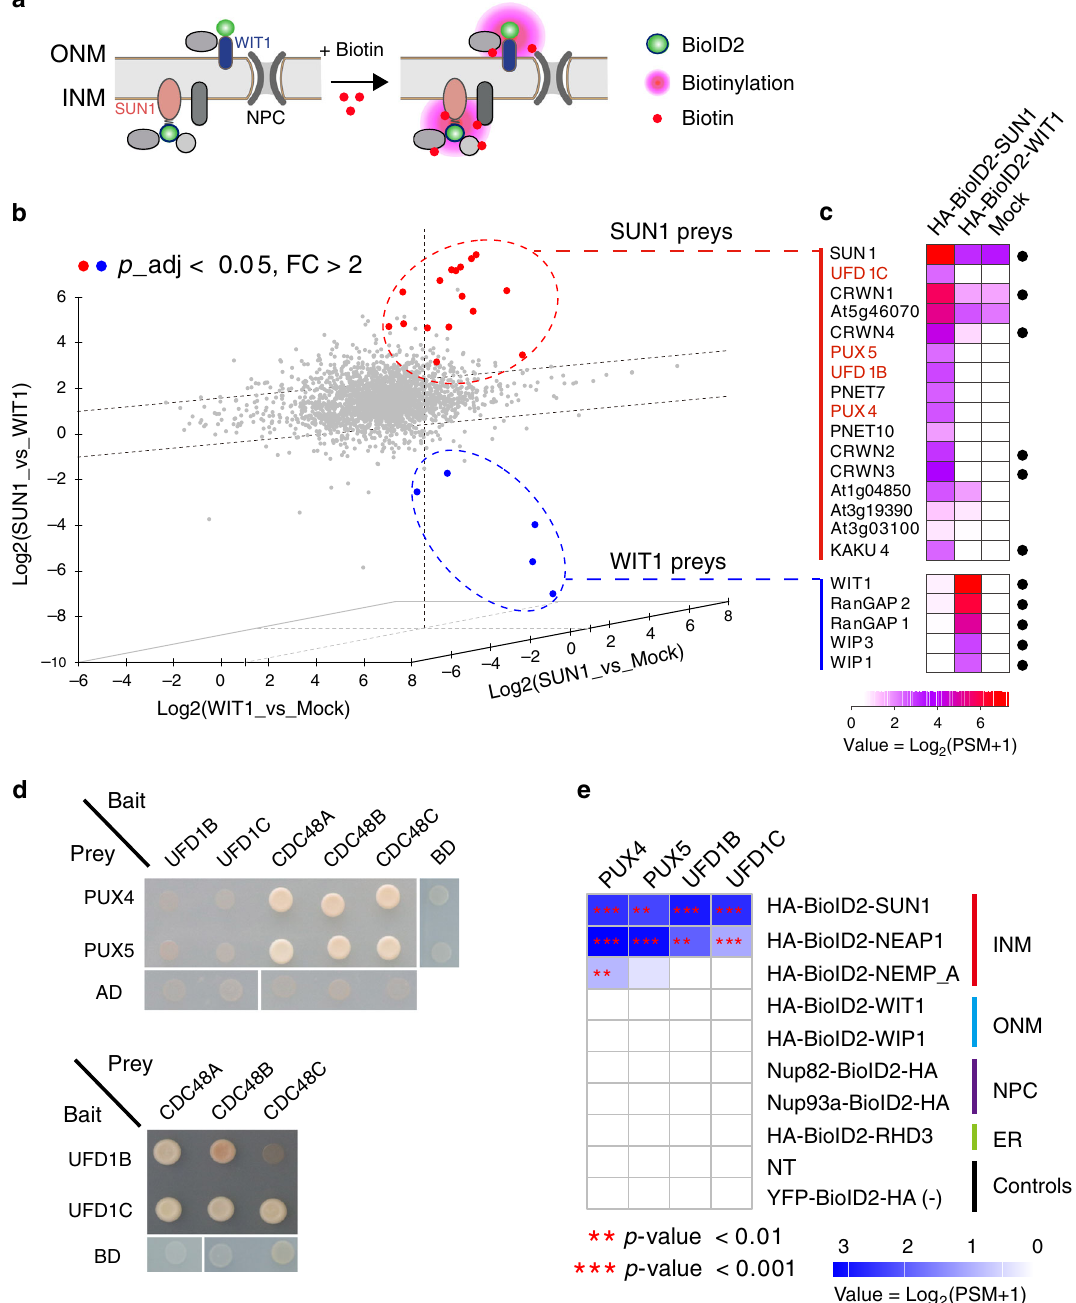
Fig. 1 The CDC48-dependent proteolysis machinery associates with integral INM proteins. a Identi fi cation of proteins that are speci fi cally associated with SUN1 at the INM using proximity labeling. The ONM protein WIT1 serves as a control to exclude proteins associated with both the INM and the ONM. b Pairwise ratiometric analyses of PL-LFQMS data using 35S: HA-BioID2-SUN1 ( + biotin), 35S: HA-BioID2-WIT1 ( + biotin), and 35S: YFP-BioID2-HA ( − biotin) samples. Three biological replicates for each sample were included in the analyses. Axes represent the log values of peptide intensity ratio (FC, fold-change) between two samples. Signi fi cantly enriched proteins in one sample were de fi ned by cutoffs FC>2 and adjusted p -value < 0.05 (linear model F -test) relative to both controls. Proteins signi fi cantly enriched in HA-BioID2-SUN1 and HA-BioID2-WIT1 samples are labeled in red and blue dots, respectively. c Heatmap showing transformed and averaged peptide spectrum match (PSM) values of signi fi cantly enriched proteins in HA-BioID2-SUN1 and HA-BioID2-WIT1 samples. Known SUN1 and WIT1 interacting proteins are marked by black dots on the right. d Yeast-two-hybrid analyses among PUX4/5, UFD1B/1C, and CDC48A/B/C. Diploid yeasts after mating were grown on QDO medium (SD-Leu/-Trp/-His/-Ade) for 3 days. Similar results have been obtained twice. e Transformed and averaged PSM data of PUX4, PUX5, UFD1B, and UFD1C from PL-LFQMS experiments using BioID2-tagged bait proteins from the inner nuclear membrane (INM), the outer nuclear membrane (ONM), the nuclear pore complex (NPC), and the endoplasmic reticulum (ER). Three biological replicates for each sample were included for analysis. Biotin-treated WT non-transgenic plants (NT) and YFP-BioID2-HA plants without biotin treatment were served as controls. Asterirks (** and ***) represent signi fi cant enrichment with p -value < 0.01 and 0.001 (linear model F -test), respectively, compared to both controls. MS data are available through PRIDE (Identi fi ers PXD015919 and PXD015920) and see Supplementary Data 2 for the dataset